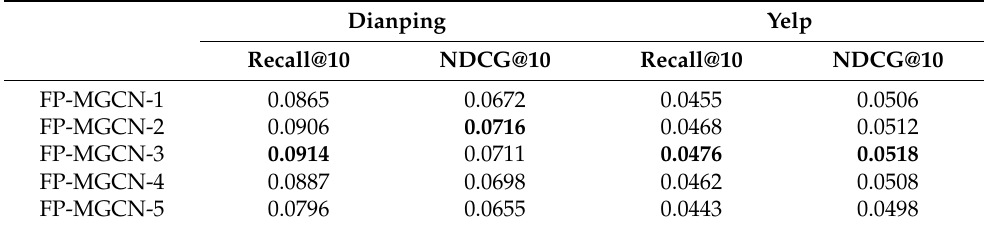
Table 3. The effect of different embedding propagation layers on the